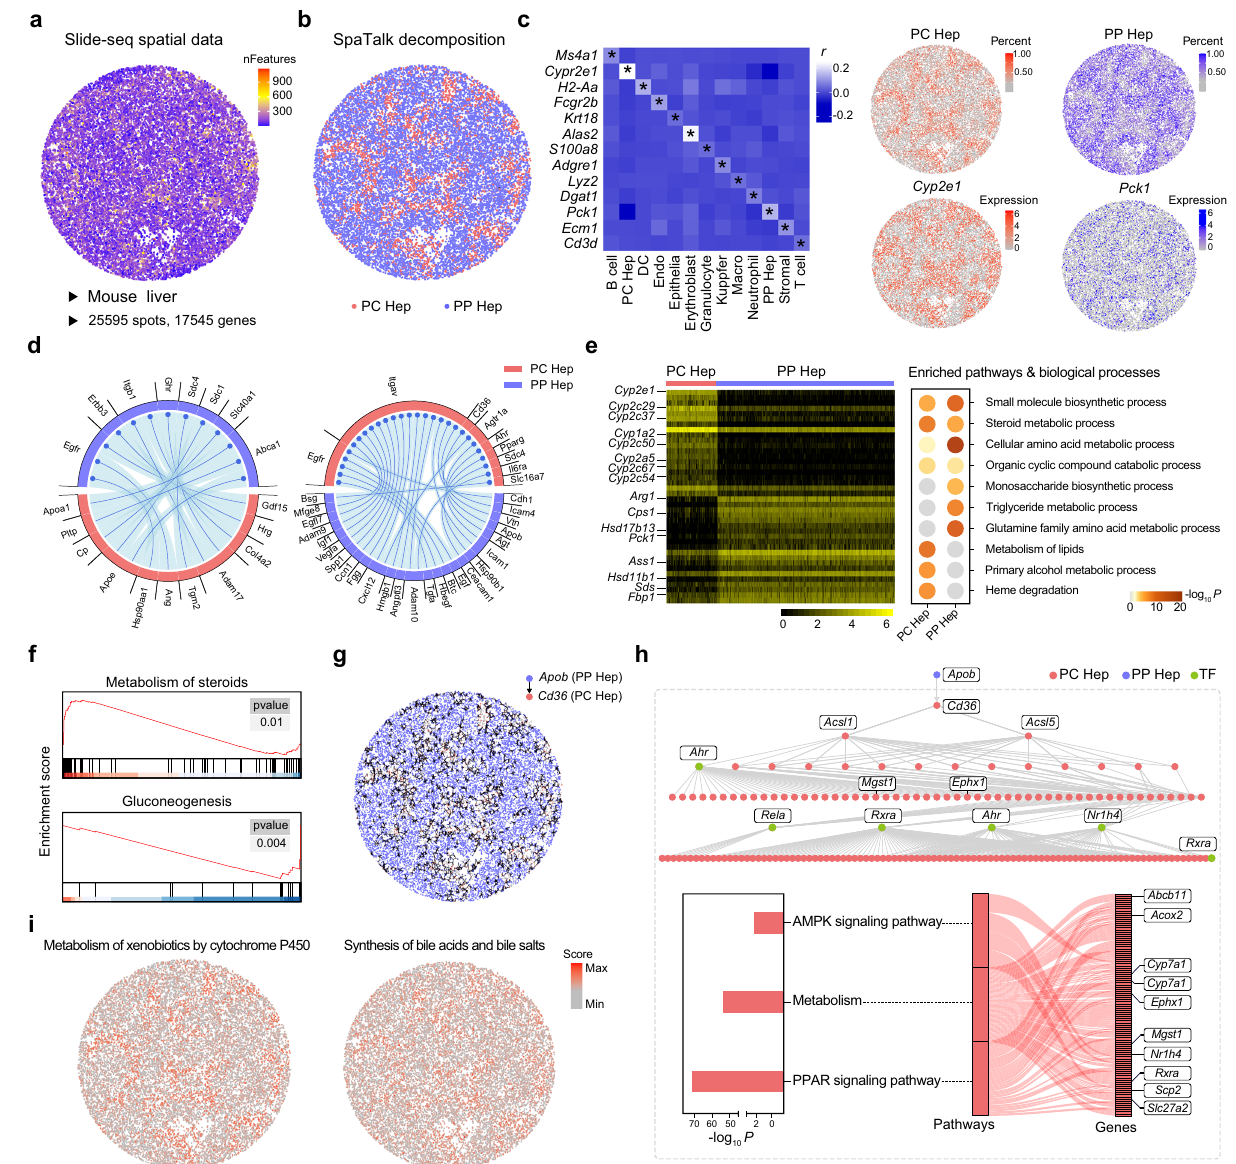
Fig. 3 | Modulation of periportal hepatocytes on the metabolic micro- environment sensed by pericentral hepatocytes. a Slide-seq spot-based ST dataset of the mouse liver involving 25,595 spots and 17,545 genes. b Cell-type decomposition by SpaTalk. PC, pericentral; PP, periportal; Hep, hepatocytes. c ScaledPearson ’ scorrelationcoef fi cientsbetweentheexpressionofknownmarker genesandthepercentforeachcelltype.Endo,endothelialcells;DC,dendriticcells; Macro, macrophages. d Enriched LRIs that mediate cell – cell communications between pericentral and periportal hepatocytes. e Signi fi cant differentially expressed genes (DEGs) between periportal and pericentral hepatocytes assessed